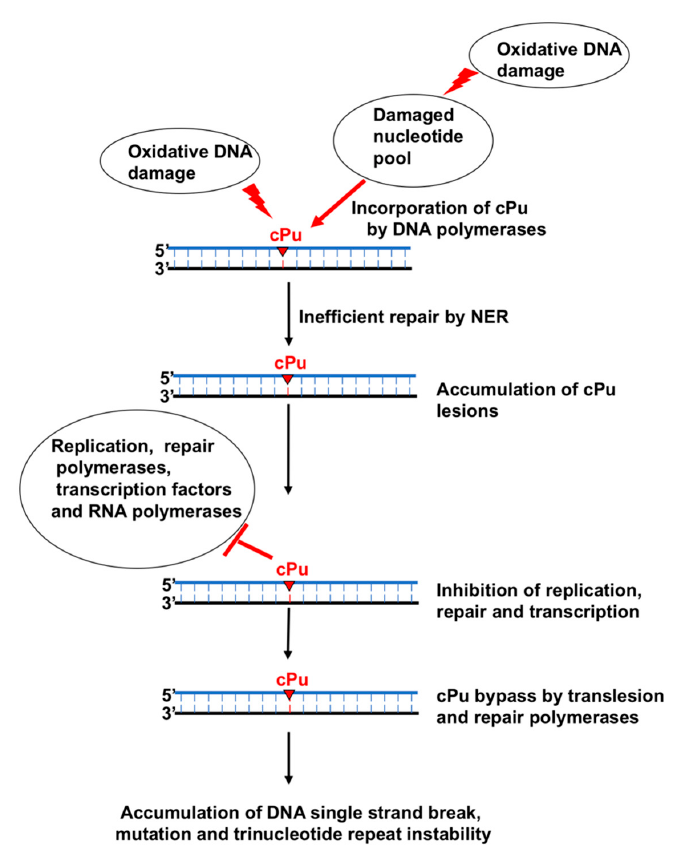
Figure 8. Accumulation of cPu disrupts DNA replication, repair, and gene transcription, leading to lesion bypass, mutations, and genome instability.